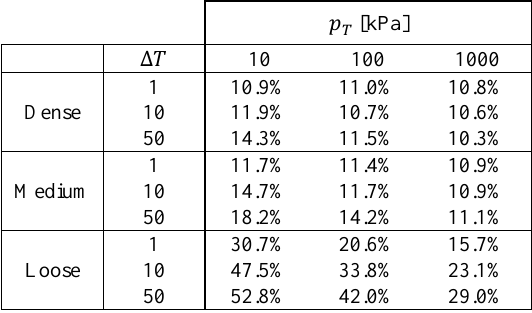
Table 6 . Differences in Δ𝑝 Δ𝑇 values ( Release